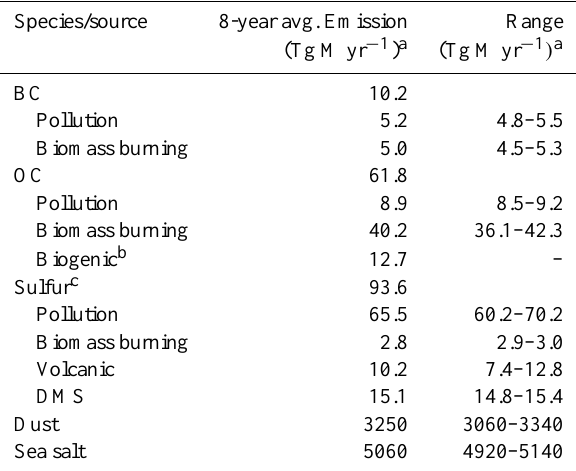
Table 1. Aerosol and precursor emissions averaged from 2000 to 2007.